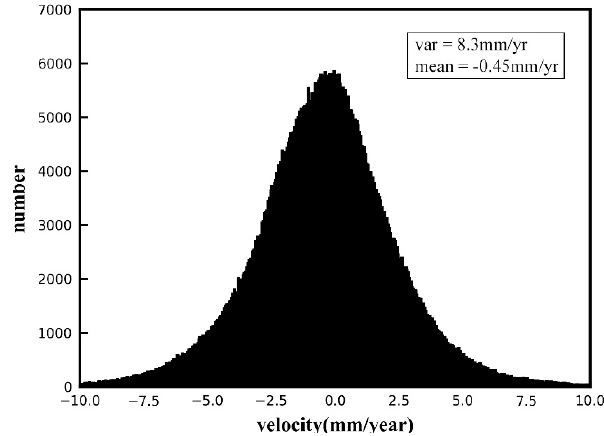
Figure 14. Motion velocity distribution of the pseudo-combination SBAS.